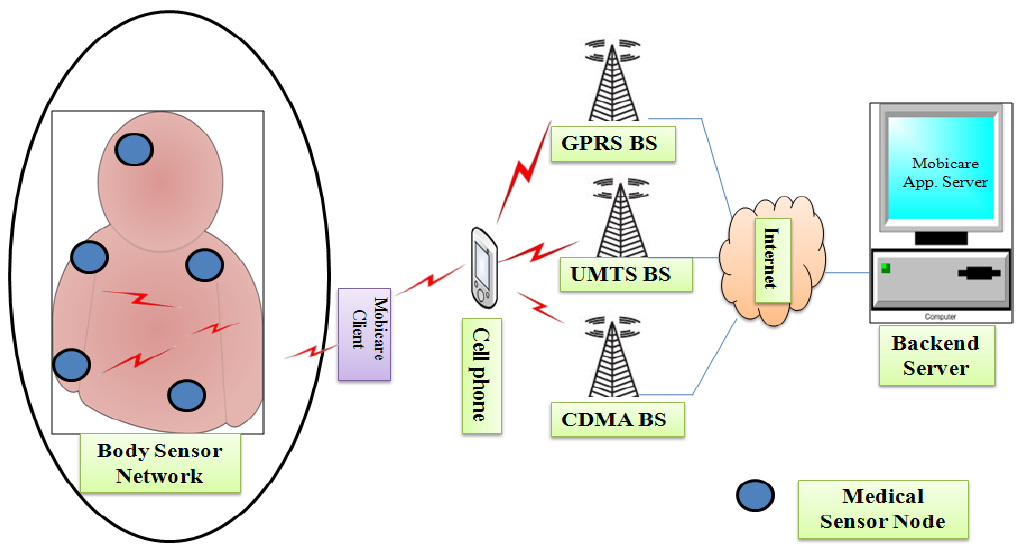
Figure 6. MobiCare patient monitoring